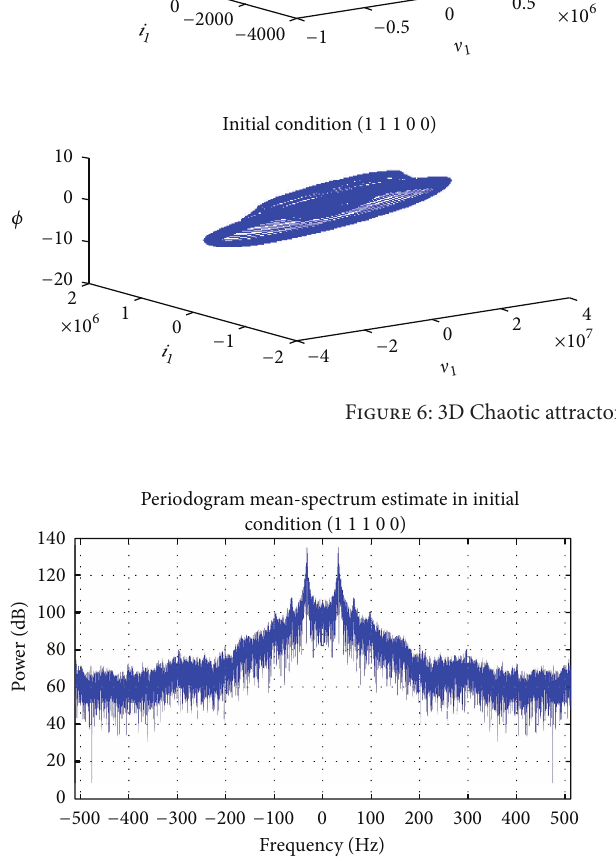
Figure 7: The self-power density spectrum chart of the chaotic